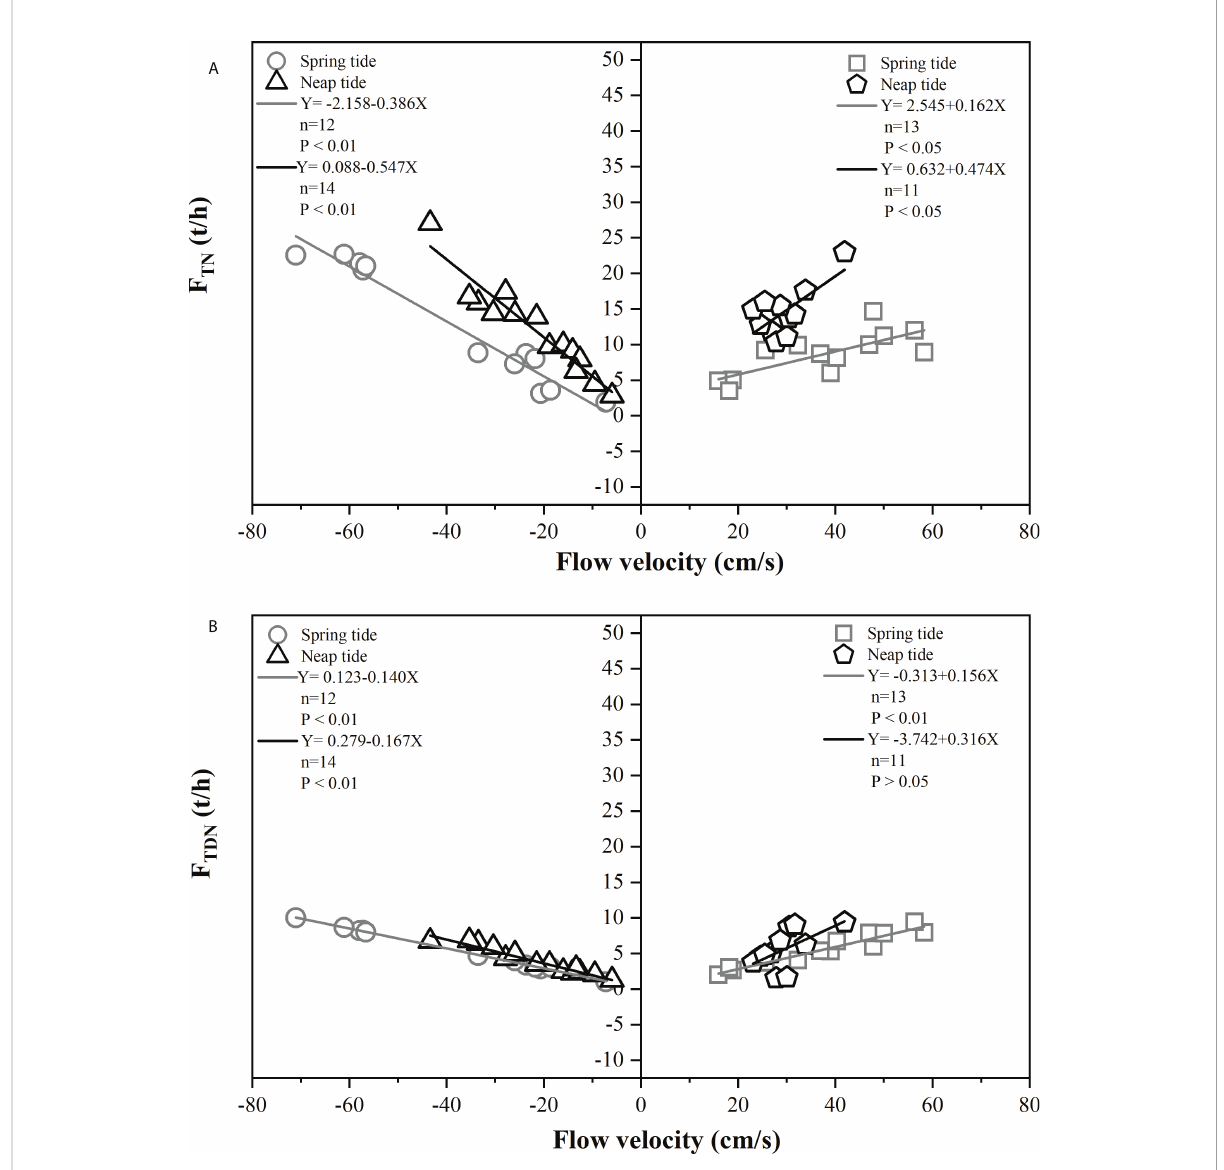
FIGURE 5 Linear regression analysis of FTN (A) and FTDN (B) with fl ow